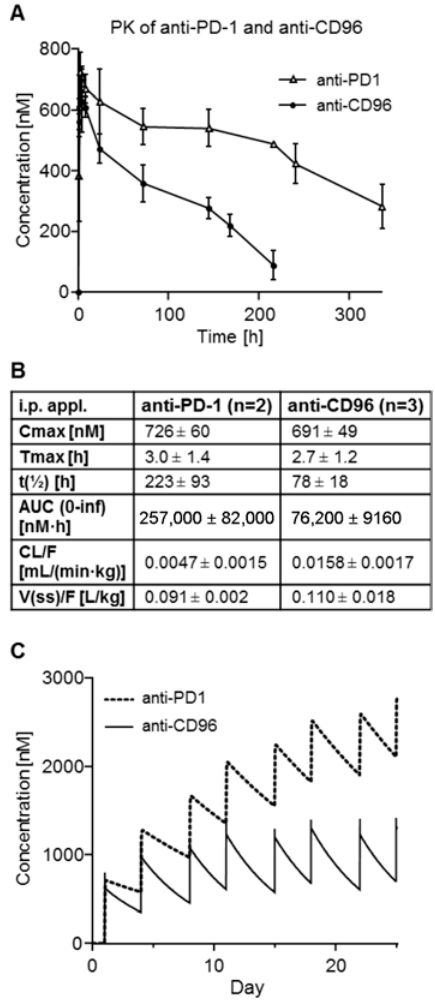
Figure 2. PK studies of anti-PD-1 and anti-CD96 in mice after single i.p. application. ( A ) Mean plasma concentration–time profiles of anti-PD-1 and anti-CD96 as determined by ELISA; ( B ) mean PK parameters calculated by non-compartmental analysis; ( C ) simulated concentration–time profiles of anti-PD-1 and anti-CD96 for the tumor therapy